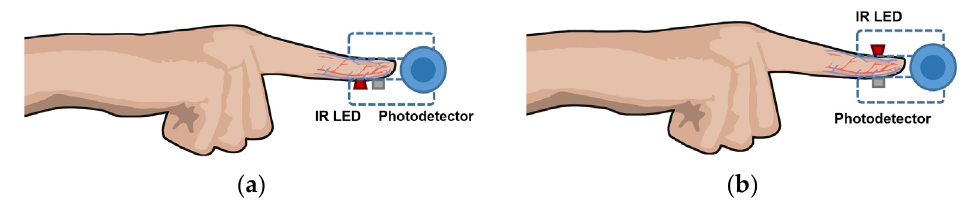
Figure 7. Illustration of ( a ) PPG in reflectance mode and ( b ) PPG in transmission mode. Based on